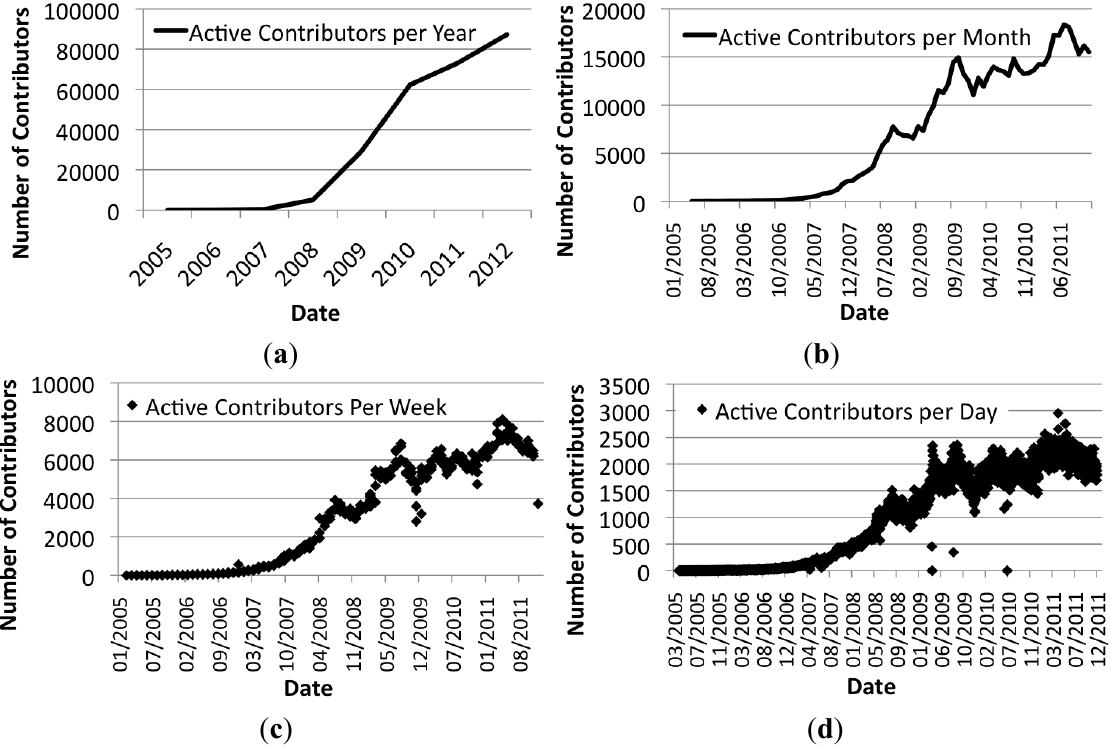
Figure 7. Number of active contributors per ( a ) year, ( b ) month, ( c ) week and ( d )